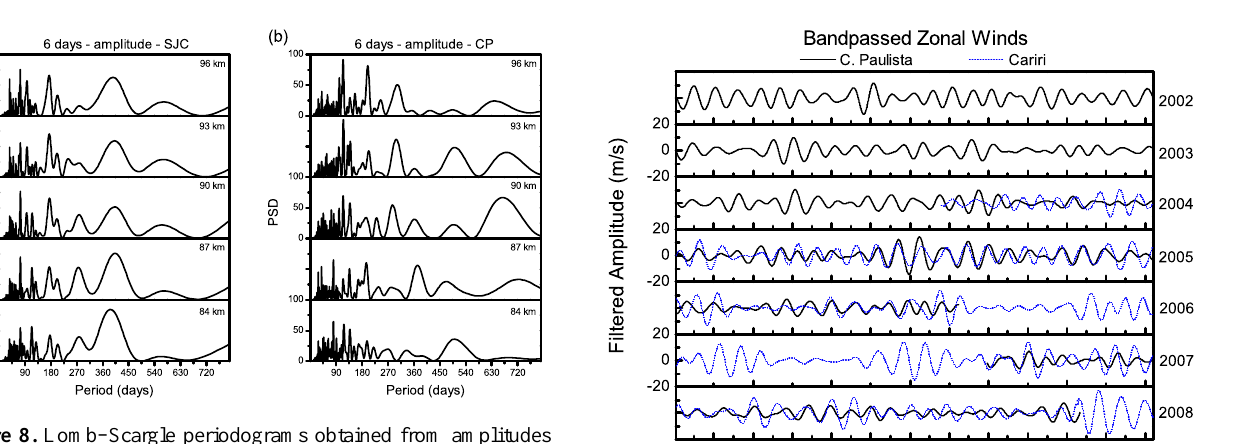
overC.Paulista(blackline),forthe years2002